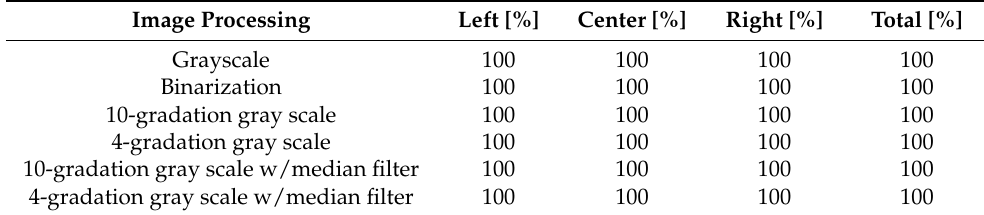
Table 6. Results of grasping in the simulation environment.